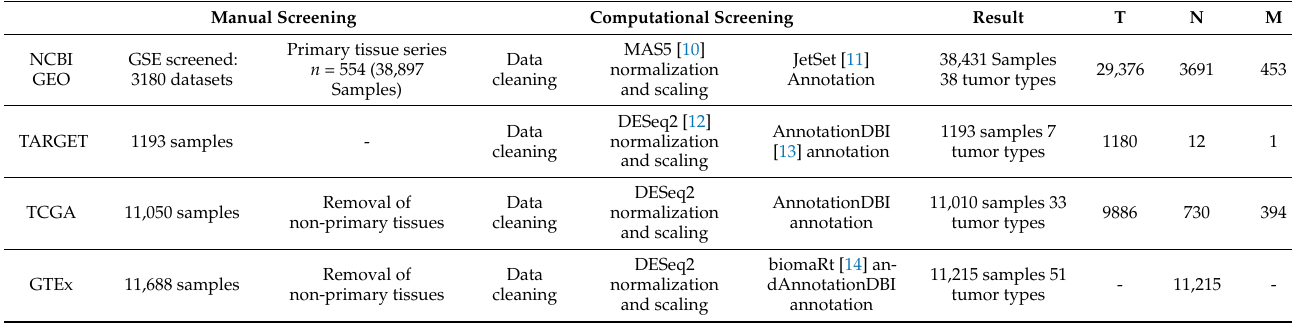
Table 1. Summary of datasets and data